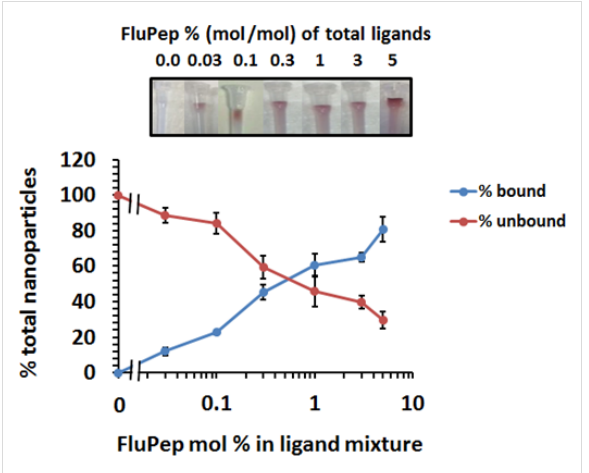
Figure 2: Purification of FluPep-ligand-functionalised gold nanoparti- cles by CM-Sepharose cation-exchange chromatography. Chromatog- raphy on CM-Sepharose was carried out with gold nanoparticles func- tionalised with different molar fractions of FluPep ligand. Top: images of columns after loading and washing with PBS. Bottom: quantification by absorption at 450 nm [18] of unbound (flow-through and PBS wash fractions) and bound (eluted with 2 M NaCl) fractions as a percentage of total nanoparticles applied to the column. Results are the mean ± SD ( n =